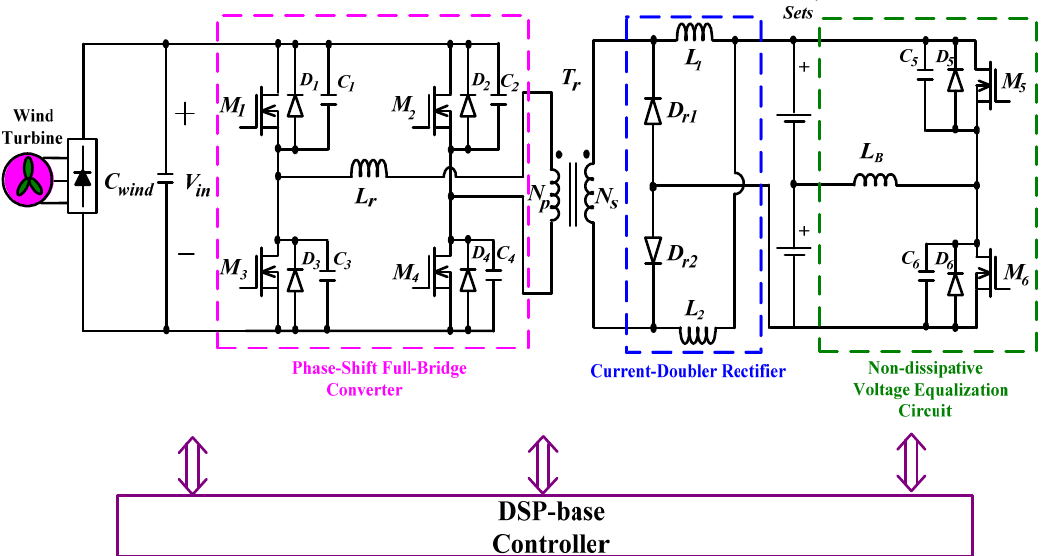
Figure 4. Circuit structure of the proposed energy storage system for wind energy